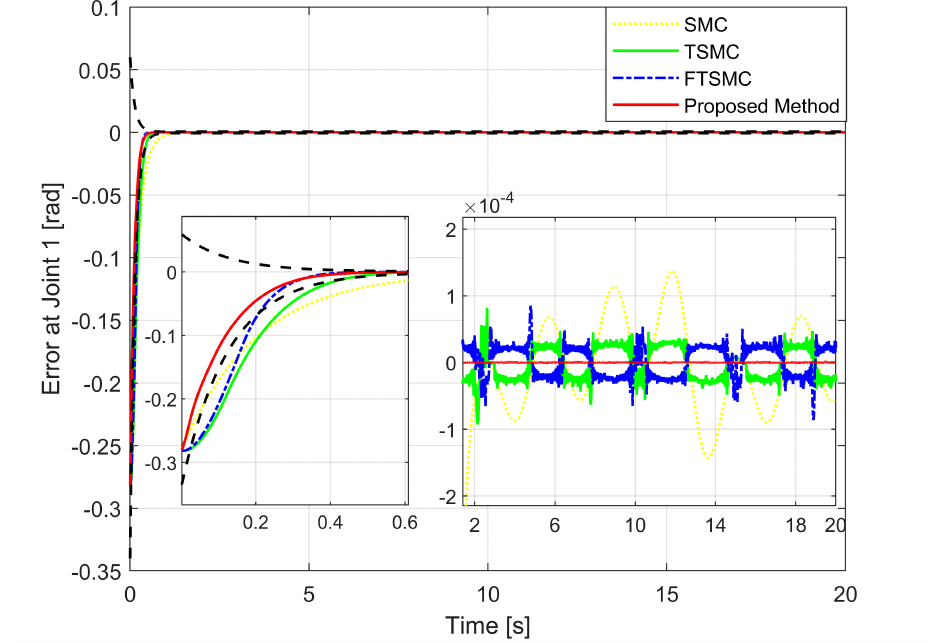
Figure 6. Tracking error of the first joint versus the desired